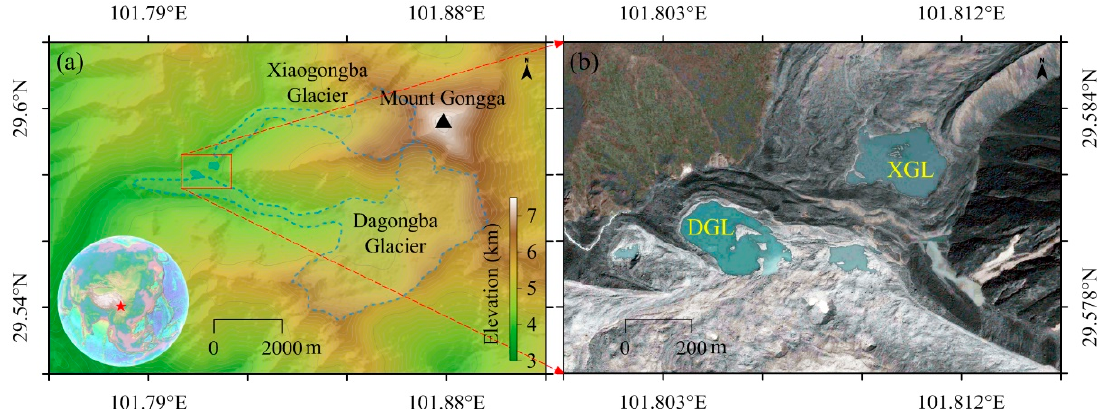
Figure 1. ( a ) The topography and location of the study area, the blue dotted polygons show outlines of the Gongba Glacier. ( b ) The Google Earth image of the Xioagongba Glacial Lake (XGL) and Dagongba Glacial Lake (DGL) acquired on 5 October 2017, corresponding to the red rectangular box in ( a ).